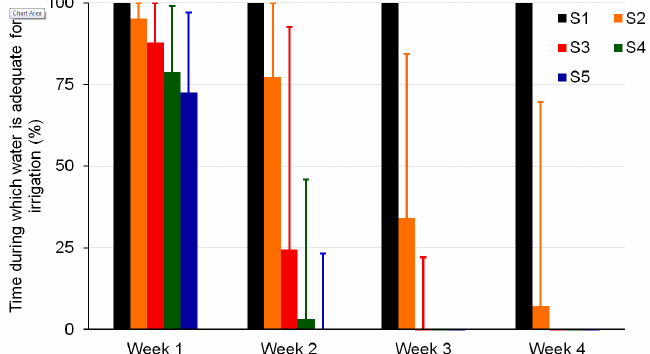
Figure 11. Percentage of time per week during which the salinity of the abstracted water is adequate for irrigation for each river discharge scenario: S1—climatological, S2—recent drought, S3—worst recent drought, S4—minimum river flow, and S5—worst-case scenario.